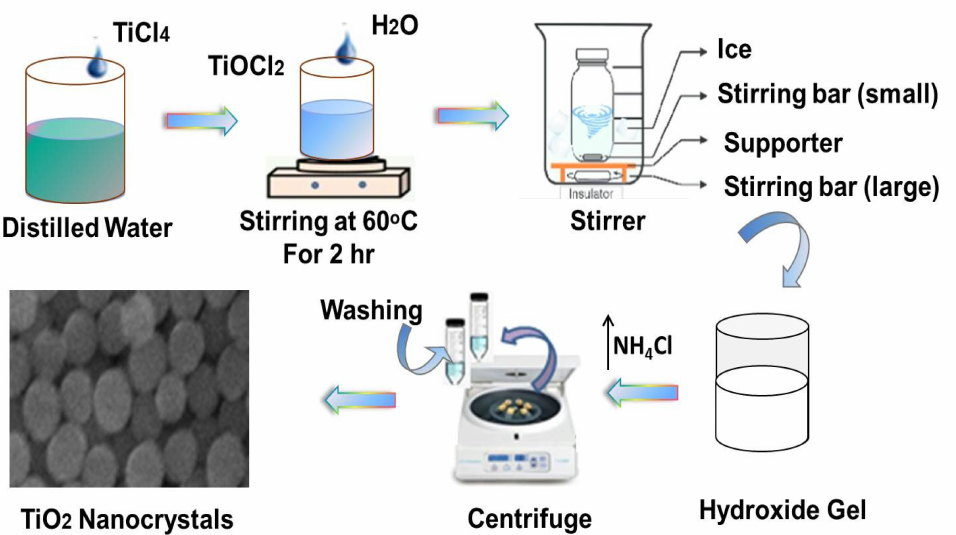
Figure 1. Schematic illustration of the TiO 2 nanoparticles synthesis